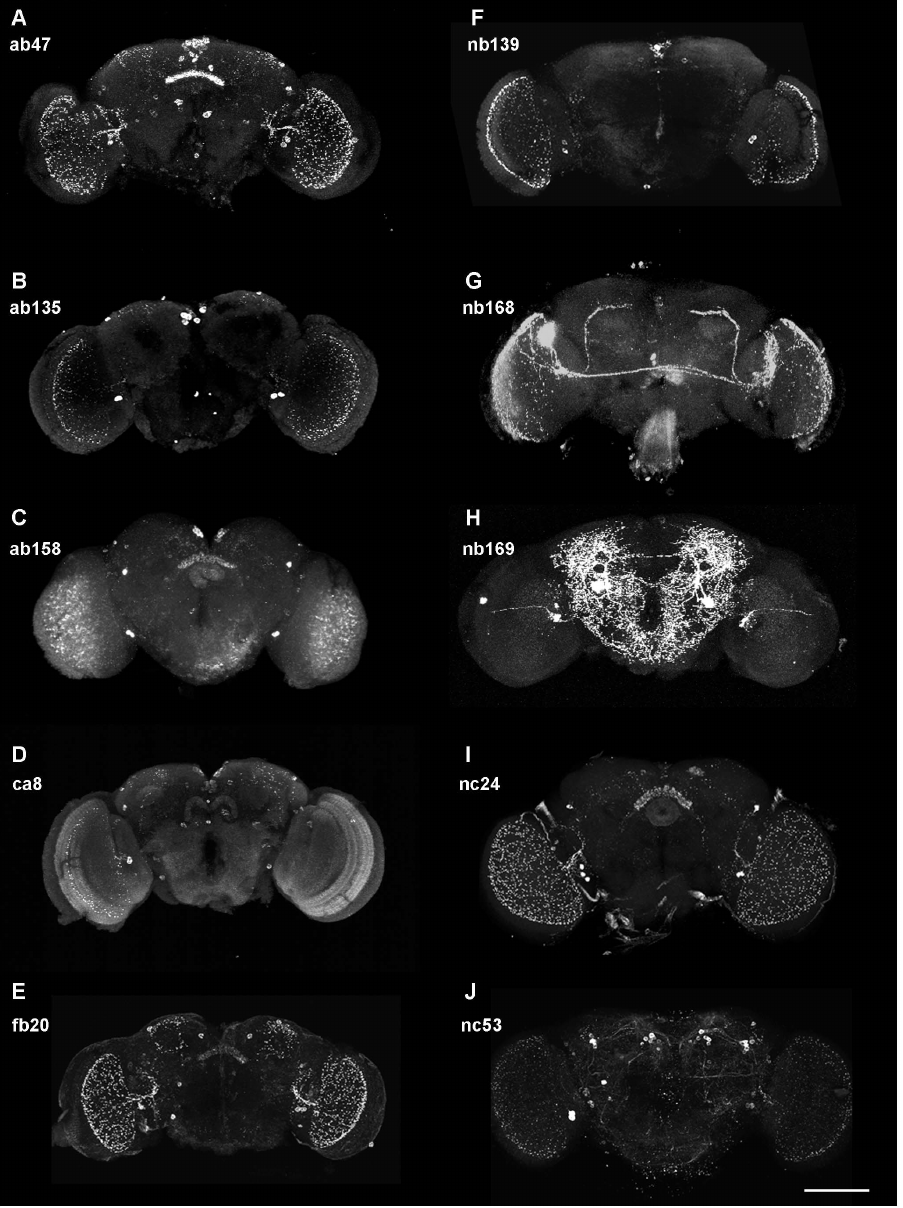
Figure 1. Z-projections of confocal stacks of whole-mount adult Drosophila brains (frontal view) stained with ten different monoclonal antibodies of the Wu¨rzburg hybridoma library. Note in (H) that the bright spot at the left rim of the projection is due to a staining artefact from outside the brain. Scale bar 100 m m.